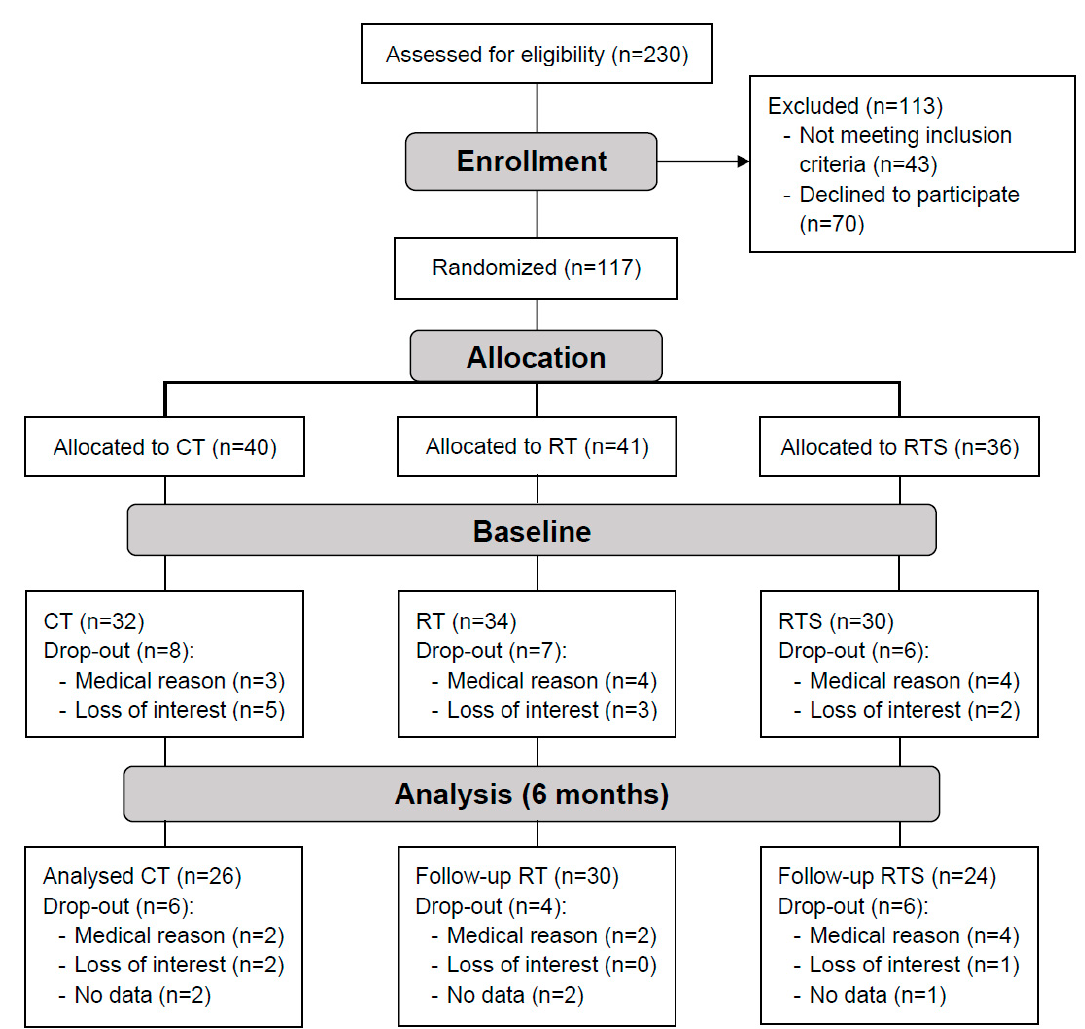
Figure 1. Participants flow diagram, Vienna Active Ageing Study.